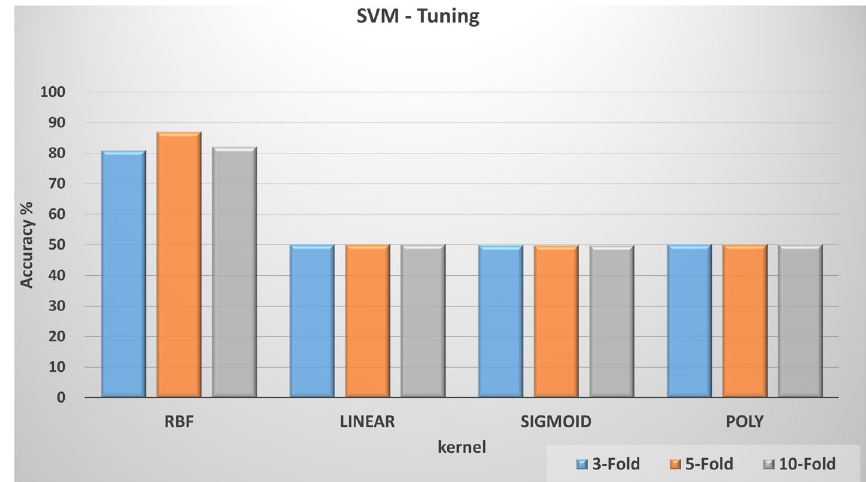
Fig. 7 One‑class SVM tuning and